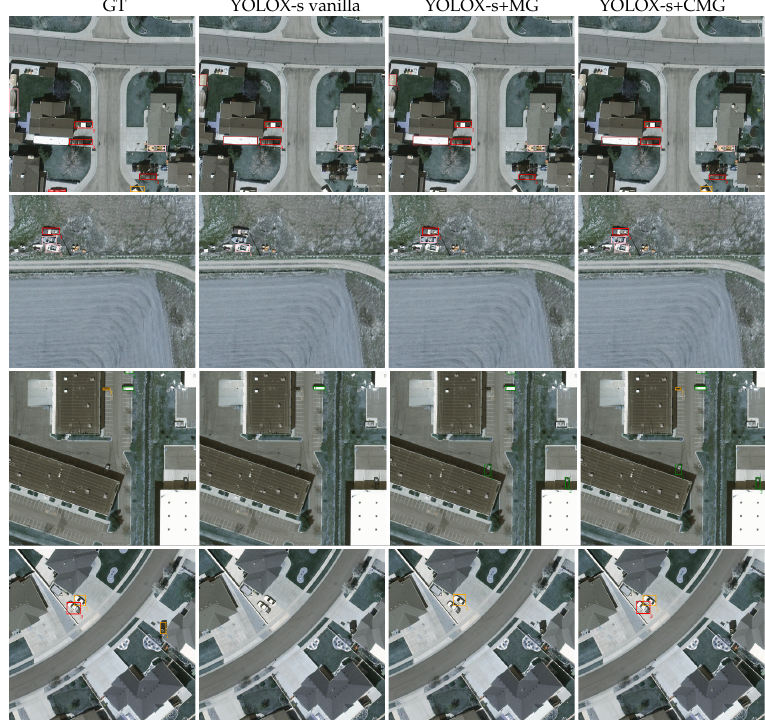
Figure 5. Qualitative results of YOLOX-s on VEDAI25. The contrastive mutual guidance helps to recognize intricate objects. The number and color of each box correspond to one of the classes, i.e., (1) car, (2) truck, (3) pickup, (4) tractor, (5) camper, (6) ship, (7) van, and (8) plane.